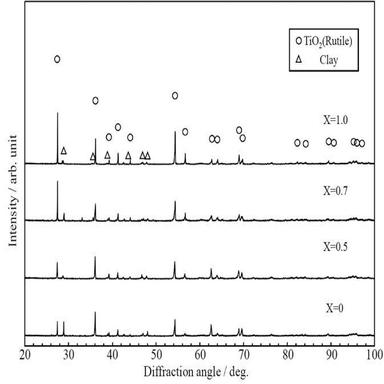
XRD patterns of TiCXN1-X-TiCrNbMoTa cylindrical samples after the thermogravimetry analysis.